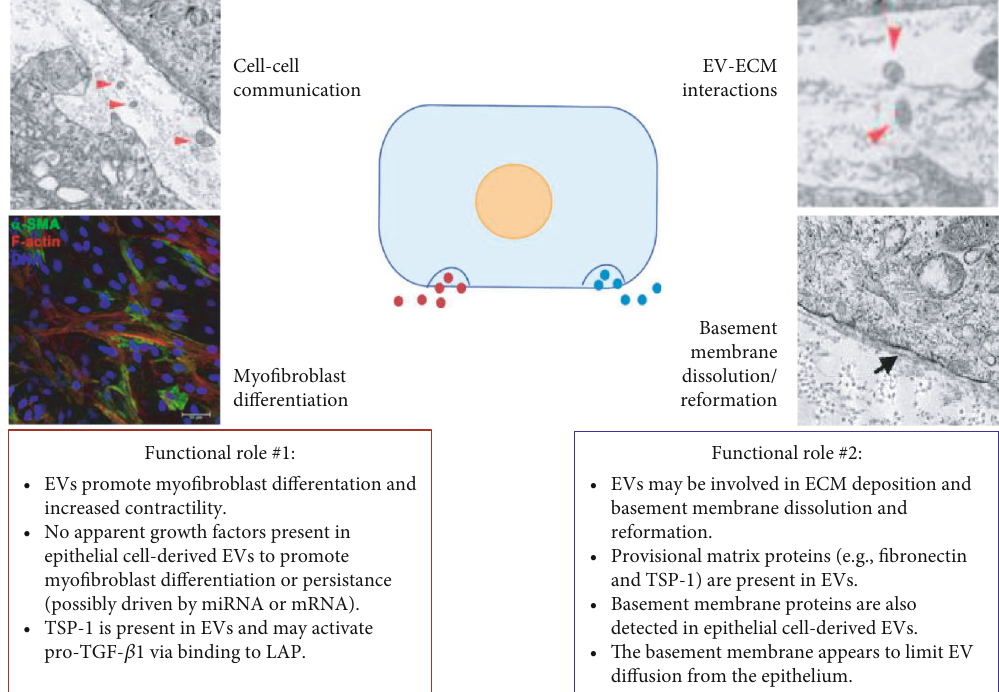
Figure 6: Proposed functional roles of EVs in the cornea. The presence of EVs ( red arrowheads ) dispersed in the ECM of a self-assembled corneal fi broblast construct. A basement membrane ( black arrow ) forms between corneal epithelial cells and the stromal matrix. Images were modi fi ed and reproduced from McKay et al. (2019 and 2020) [25, 43] based on a Creative Commons BY license (CC BY 4.0), doi:10 .3390/cells9051080 and